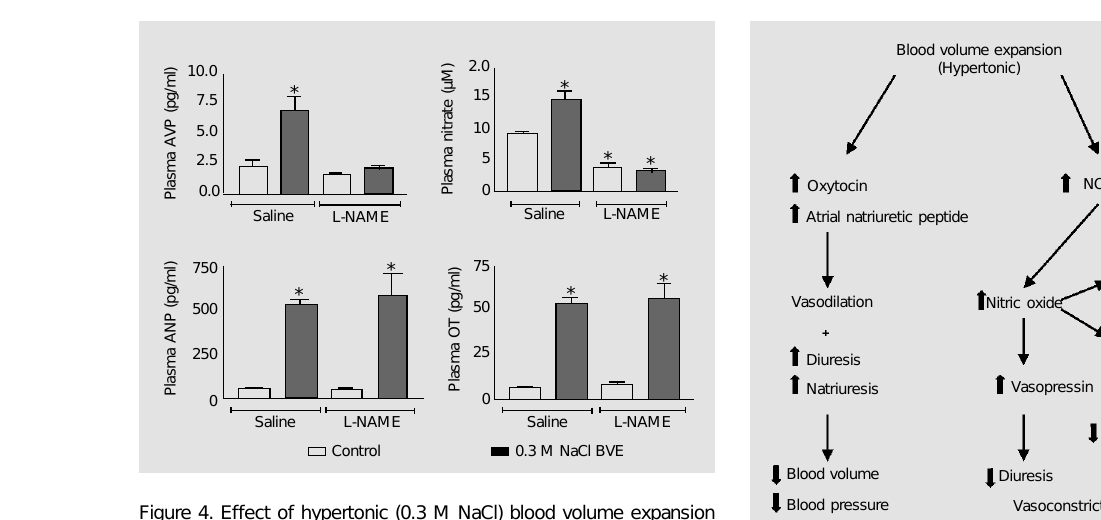
synthase.Figure 4. Effect of hypertonic (0.3 M NaCl) blood volume expansion (BVE) in rats pretreated or not with a NOS inhibitor (L-NAME, 10 mg/ 100 g body weight, 30 min before) on plasma levels of nitrate, vasopressin (AVP), oxytocin (OT), and atrial natriuretic peptide (ANP).